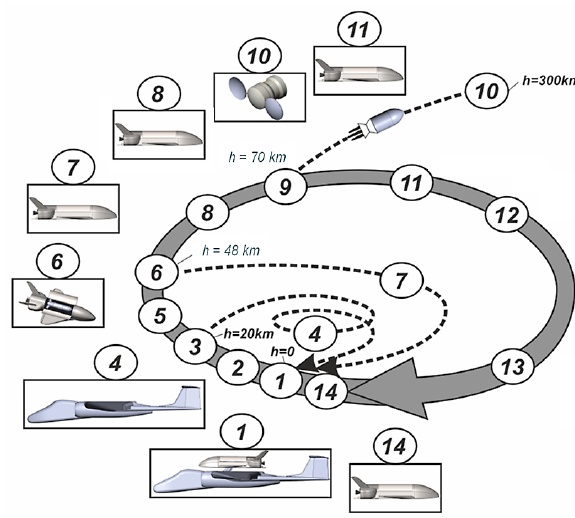
Figure 1. Preliminary LatLaunch launching system mission